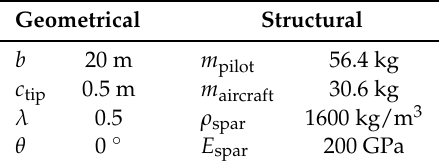
Table 5. Geometrical and structural properties in the Fluid–Structure Interaction (FSI) simulation.